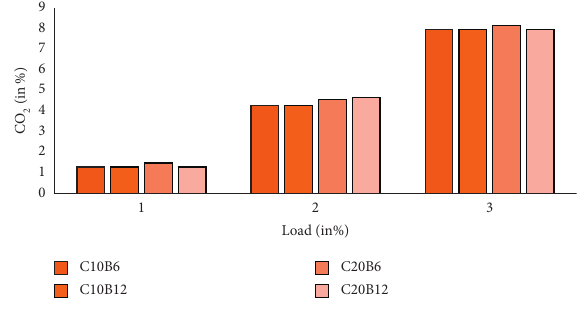
Figure 12: CO ₂ versus load for CIME samples